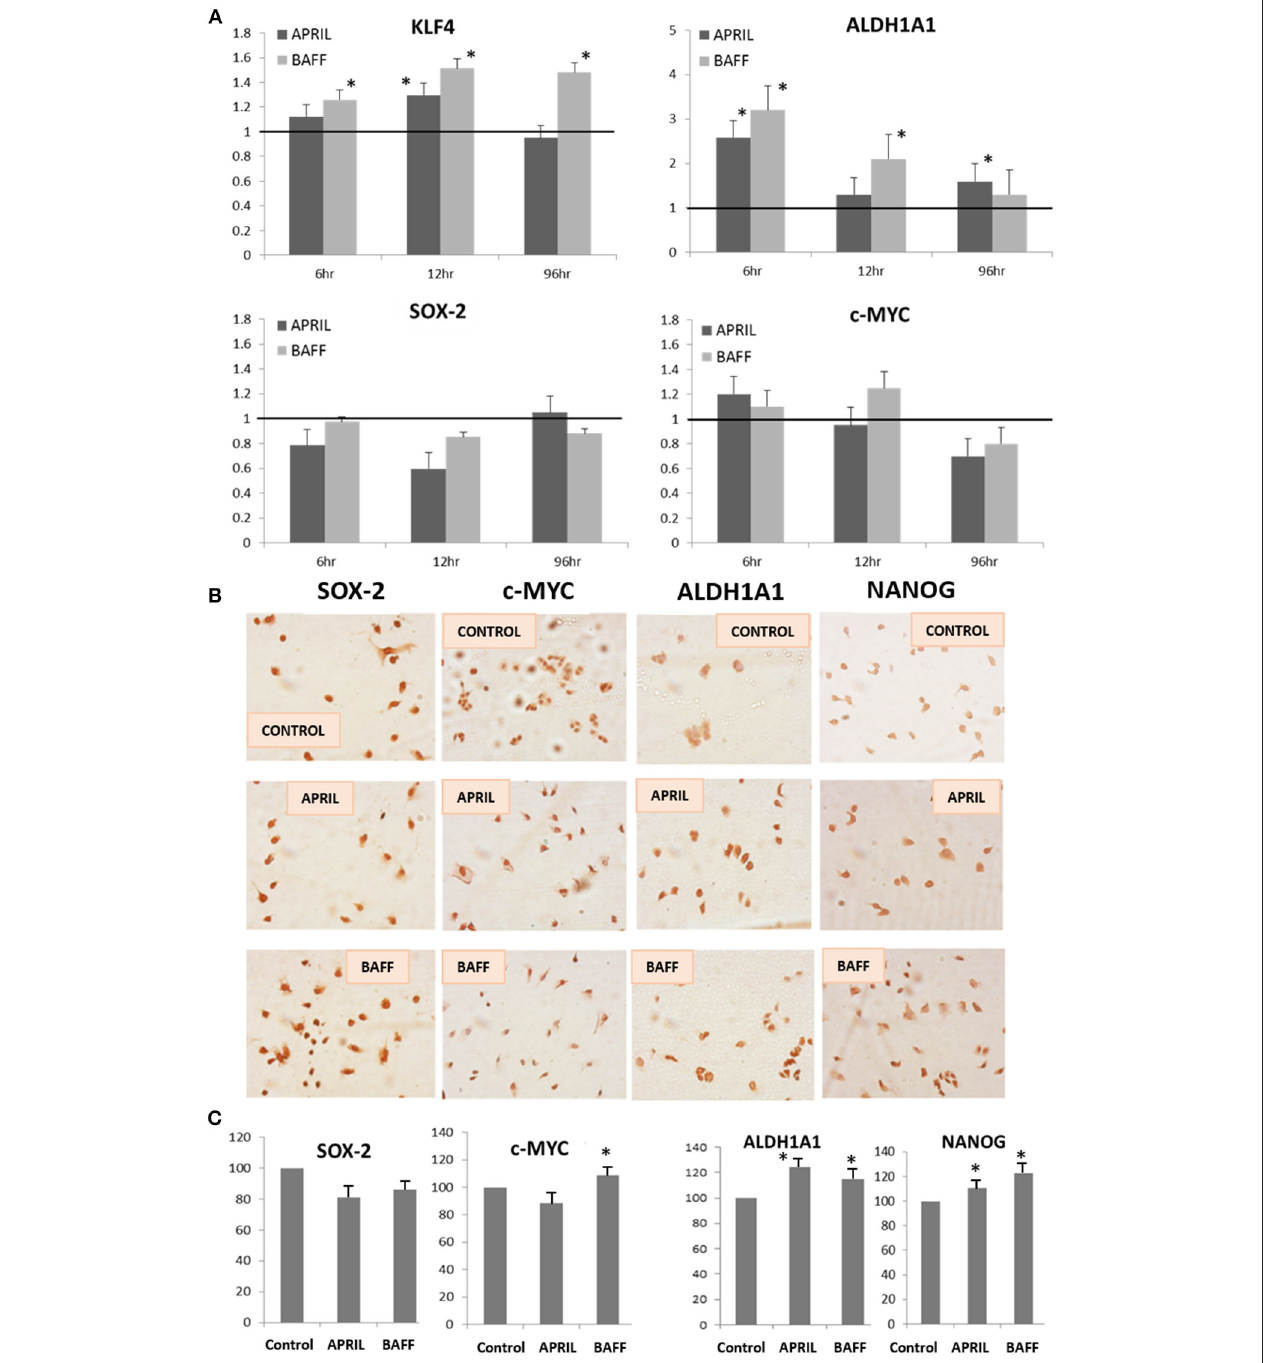
FIGURE 4 | Expression levels of pluripotency markers in T47D cells after APRIL or BAFF treatment . (A) Expression levels of ALDH1A1, KLF4, SOX-2, and c-MYC, genes (quantified by Real-Time PCR and expressed as percentage of control) after treatment of T47D cells with APRIL or BAFF (100ng/ml) for 4 days. Three independent experiments were performed (mean ± SE, *denotes p < 0.05, at least). (B,C) Expression of SOX-2, c-MYC, ALDH1A1, and NANOG proteins (assayed by immunocytochemistry). Representative images of three independent experiments are presented (B) Quantification of the proteins’ expression levels was performed in at least 10 cells in three different photos for both control and treated cells using Image J and is expressed as percentage of control (mean ± SE, (C) ).